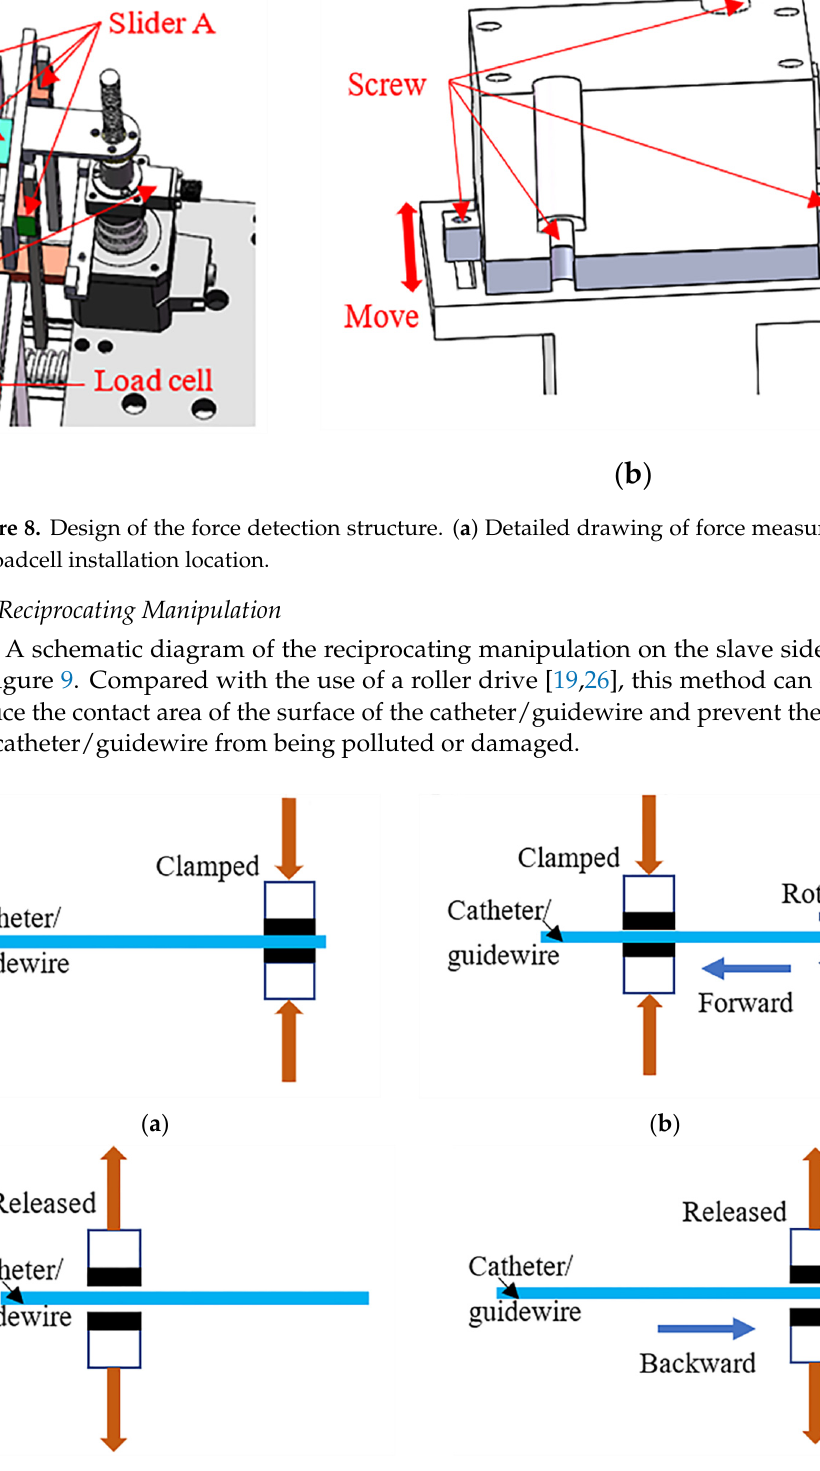
Figure 10. Schematic diagram of the co-operation of the catheter and guidewire. 4. Experimental Design and Results 4.1. Axial Force Calibration Experiment on the Slave Side We designed the experiment to verify the axial force detection structure’s effective- ness, as shown in Figure 11. Here, due to the special treatment on the surface of the cath- eter/guidewire, we used the rod to replace the catheter/guidewire without affecting the experimental result. The rod material is acrylic. The left side of Figure 11c is a load cell fixed on the ball screw, which is marked as L1 in the paper. The ball screw is connected to the stepper motor (ASM46AA, ORIENTAL MOTOR, Japan) for fixing to prevent the load cell from slipping during the experiment. The load cell shaft is directly connected to the rod through the coupling. The standard axial force is represented by F1. In the slave sys- tem, the load cell installation position is on the right of Figure 11c, marked as L2, and F2 represents the detected force. In the experimental design, in order to improve the detec- tion accuracy and avoid experimental errors, the axis of the rod and the shaft of L1 and L2 are on the same horizontal line and the same axis, as shown in Figure 11b,c. The rod is clamped by the SP. When the FP is moving, the results detected by L1 and L2 are shown in Figure 12. The data sampling frequency of L1 and L2 is set to 200 ms.